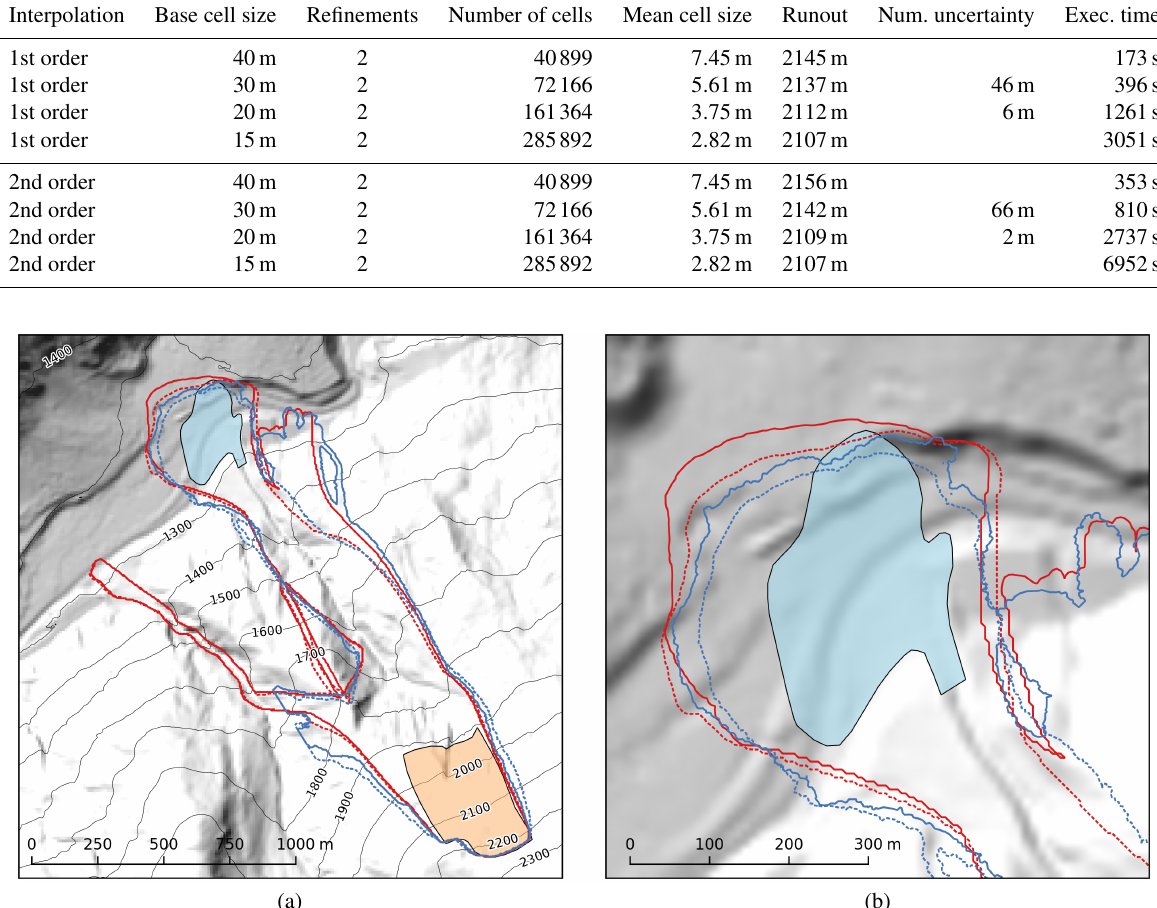
Table 1. Mesh size, runout, error estimation and execution time for different OpenFOAM simulations. Base cell size and refinements refer to parameters of cfMesh.